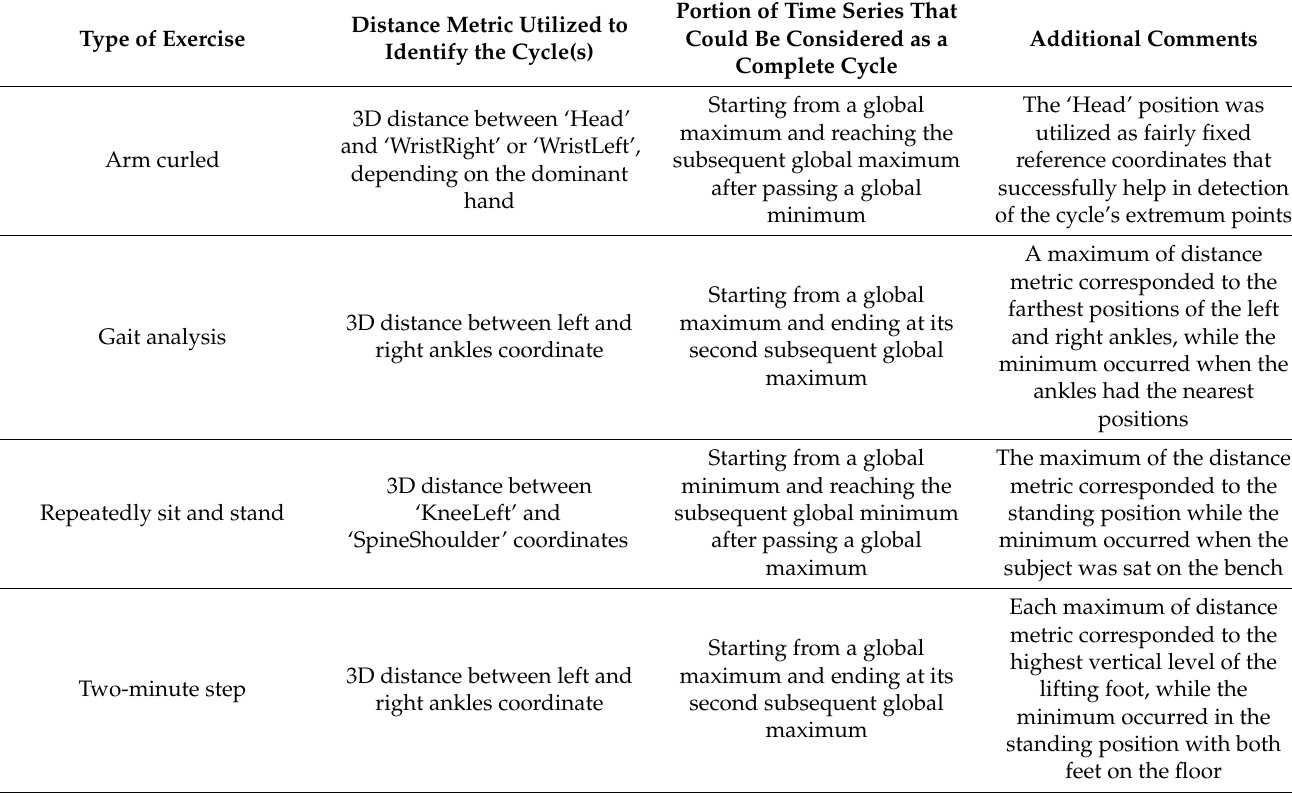
Figure 5. Temporal variation of distance metrics for the four different exercises of the present study: ( a ) ‘Arm Curled’; ( b ) ‘Gait Analysis’; ( c ) ‘Repeatedly Sit and Stand’; ( d ) ‘Two-minute Step’. For each of the exercises, one complete cycle was identified based on the extremum locations and the rules defined in Table 2. Table 2. List of distance metrics used in cycle identification of various exercises.